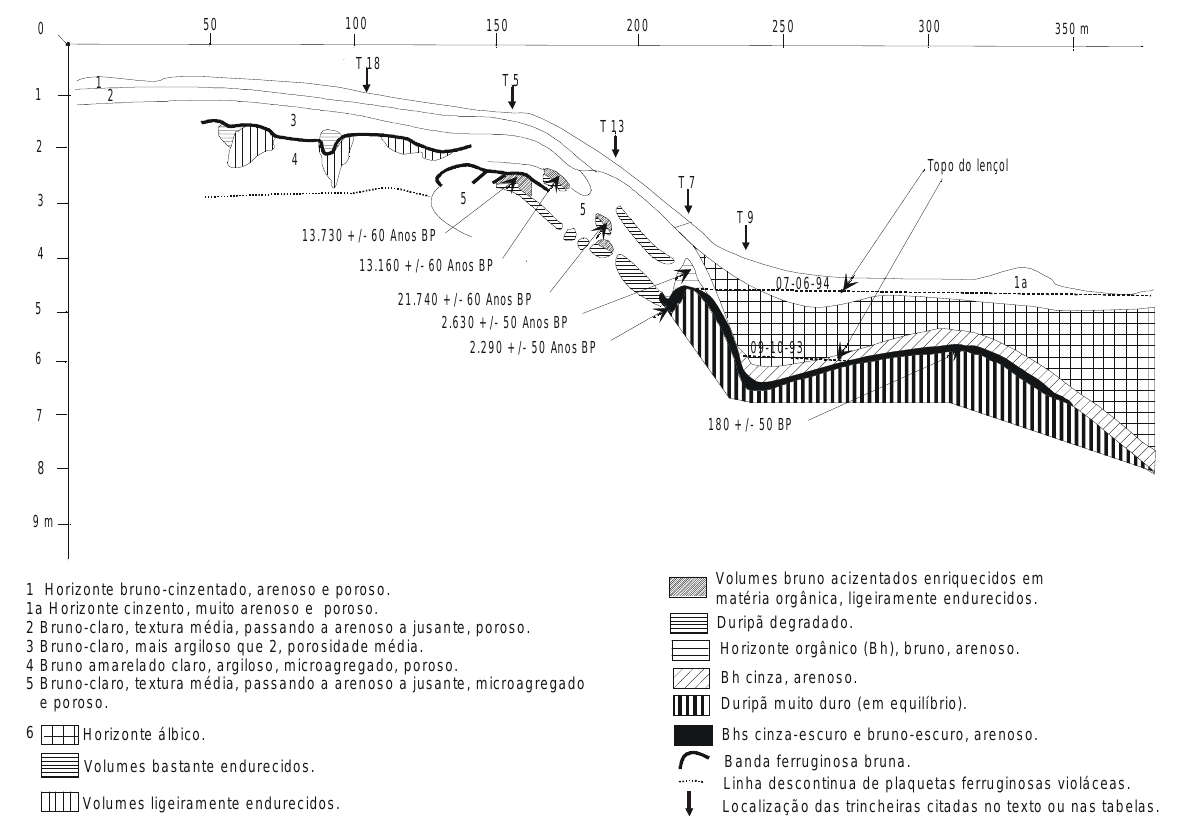
Figura 3. Distribuição espacial dos horizontes dos solos da depressão